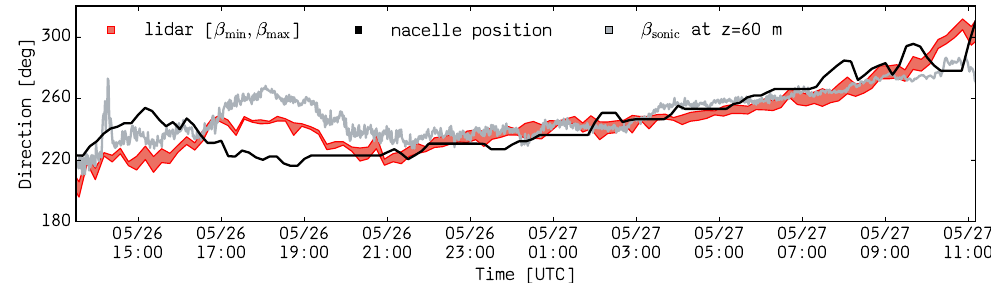
Figure 3. Wind direction as estimated from LiDAR measurements at least 0.25 D above the rotor (red line, lower limit = β min and upper limit = β max ), the turbine nacelle position as measured and provided by the turbine operators (black line) and the wind direction at 60 m (gray line) measured with a sonic anemometer ( β sonic ) and averaged over 2 min for